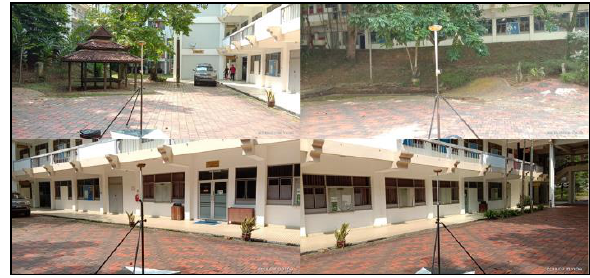
Figure 3 . GPS observation at point